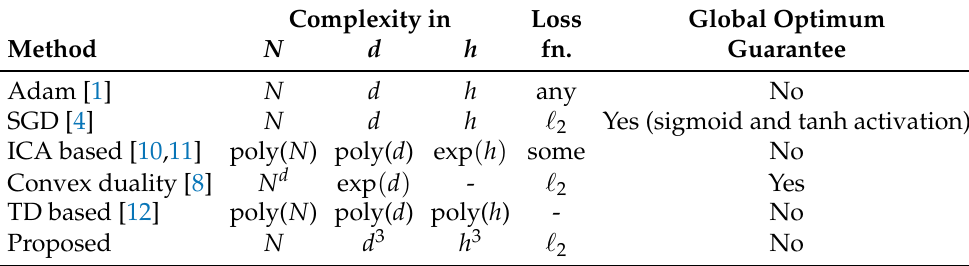
Table 1. Overview of related works with time complexity and theoretical global optimum guarantees. Complexity